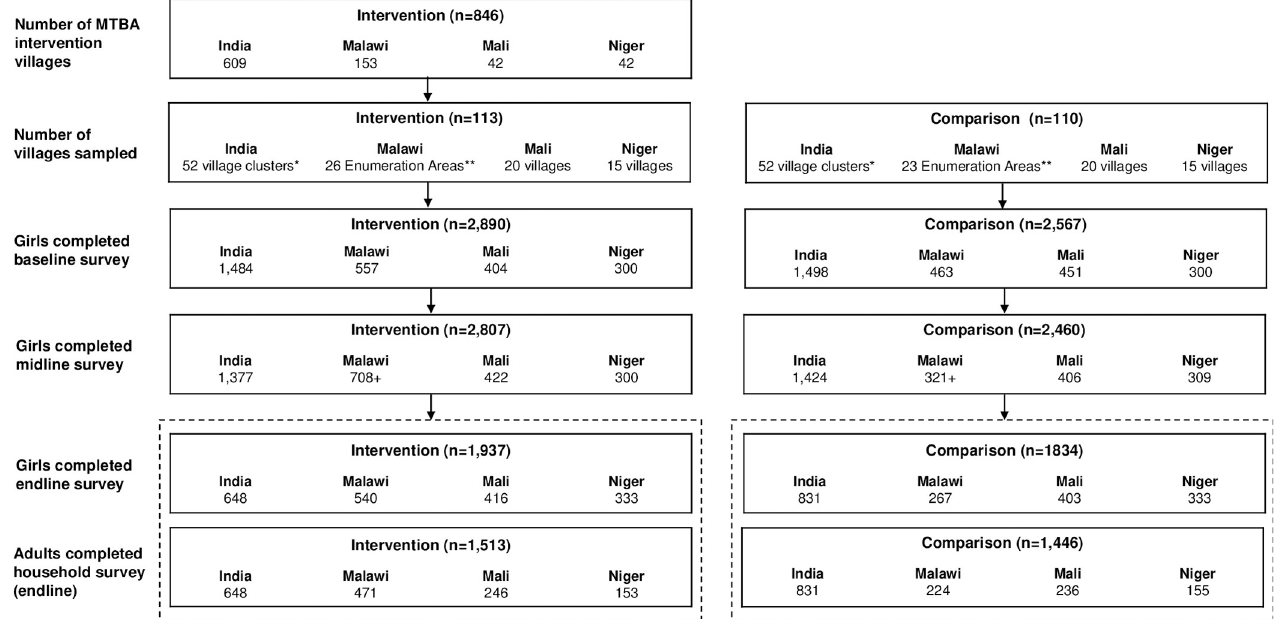
Fig 3. More Than Brides Alliance program and research samples. * If a village was smaller than 150 households, we created a village cluster grouping the small village to one or more neighboring villags within the same Panchayat. Village clusters were vetted by program partners. ** Enumeration Areas are geographic units defined by the Malawi National Statistical Office. We used this as the unit of measurement for sampling to maintain stability across rounds of data collection since the program used group head village (GHV) level, but those geographic units are subject to change. We mapped EAs and GHVs to "match" to each other and shared both EA and GHV assignments with program implementation staff. + Malawi comparison areas were reassigned at midline (from 26 intervention EAs to 31; from 23 comparison EAs to 14) based on contamination as the program was mistakenly implemented in planned comparison